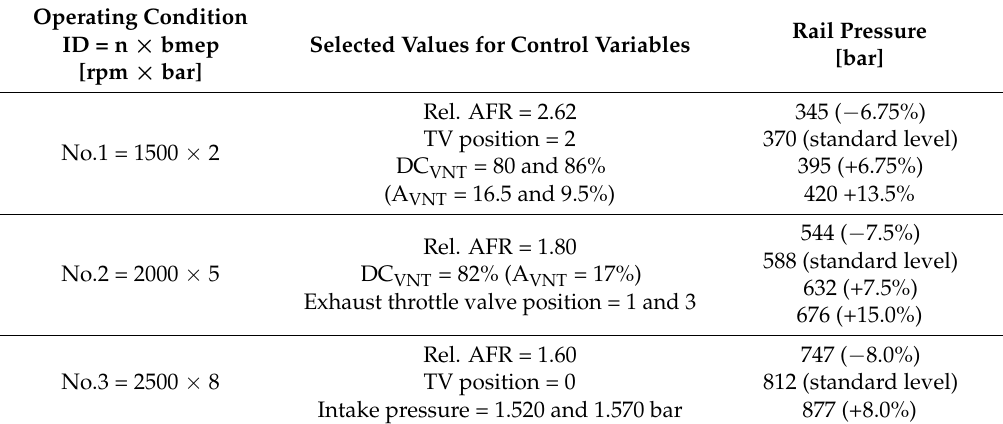
Table 6. Schedule of experimental activities for test Set 3.